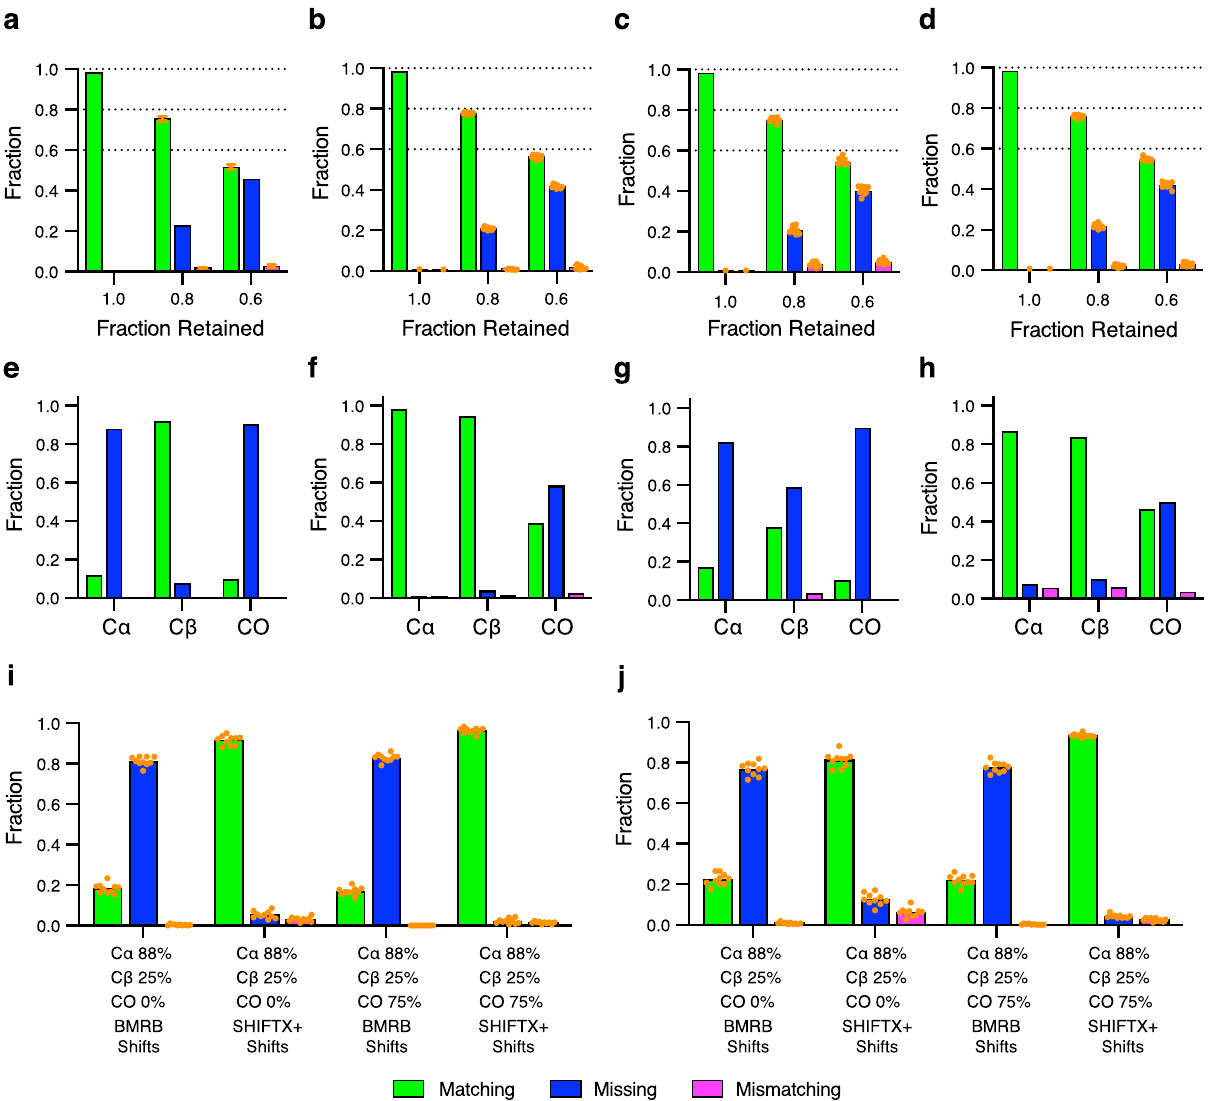
Fig. 4 | Performance of BARASA under data sparse conditions. Shown are the fractions of residues that are accurately matched (green), mismatched (magenta) or missing (i.e., unassigned) (blue) to the reference assignments. Panels a – d correspond to results from input data sets where entire spin systems were discardedfromthecrosspeaklists.Theordinateaxisisthefractionofretainedspin systems and the dashed lines indicate the maximum fraction of possible matching assignments. The effects of random spin system depletion on the analysis of MBP bothrandomly( a )andasstretchesof fi veconsecutiveresiduesbeingdiscarded( b ). A similar analysis of ecTS with either individual ( c ) or groups of fi ve consecutive spinsystemsbeingdiscarded( d ).Fortheconditions0.8and0.6fractionsretained, ten random data sets retaining the indicated fraction of spin systems were gener- ated.TheperformanceofBARASAoneachdatasetisshownasasingleorangesolid circle,withthebarheightrepresentingthearithmeticmean.Thefulldataset( “ 1.0 ”